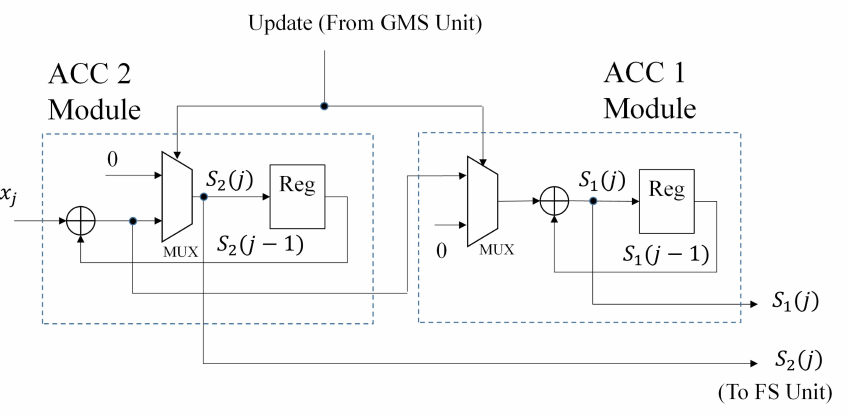
Figure 6. The architecture of the GMS unit.